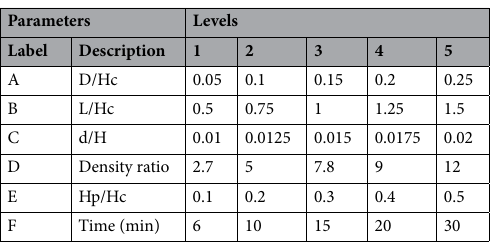
Table 9. Design and operating parameters and their levels in Taguchi DoE.